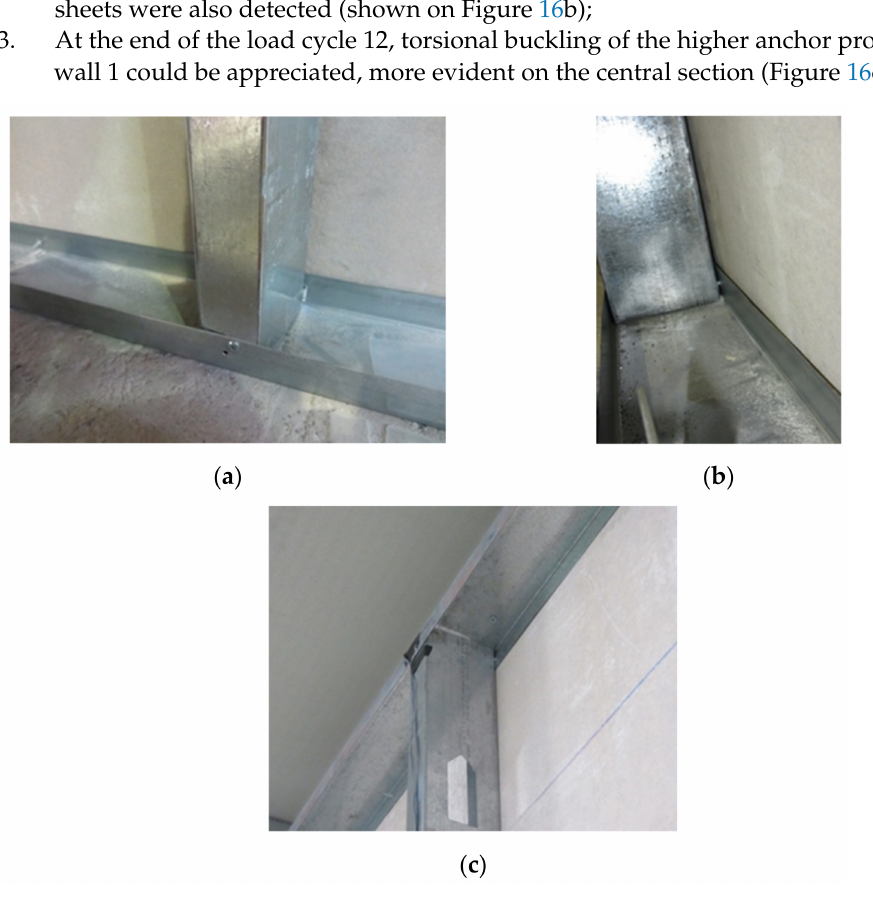
Figure 16. First identified failures modes: ( a ) Rotation of the anchor profile; ( b ) Separation between of the sheet-profile; ( c ) Torsion of the profile